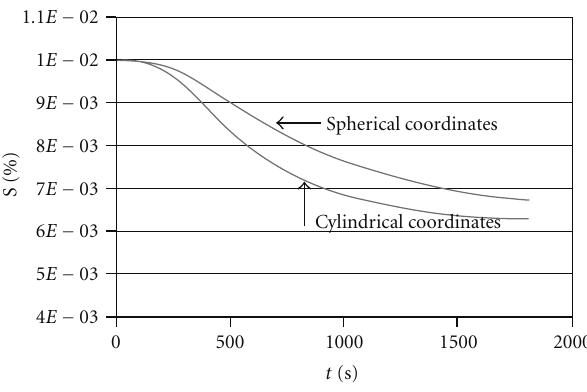
Figure 4: Sulfur elimination against time, node 30, T = 1400 ◦ C.